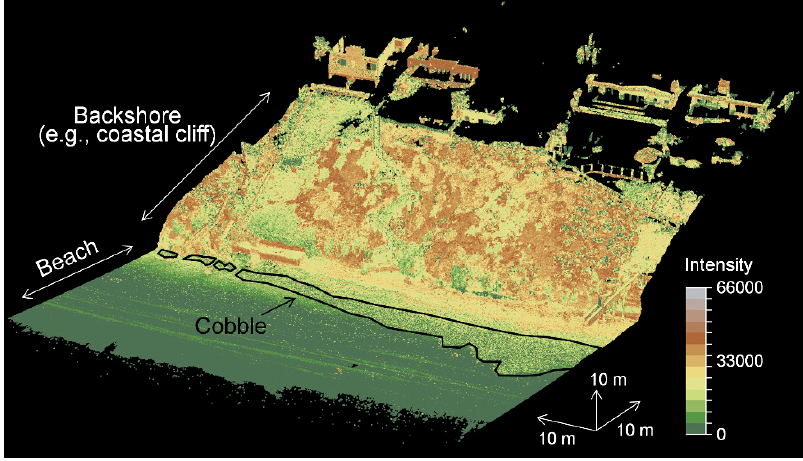
Figure 2. Example of a 3-D point cloud obtained from the mobile LiDAR system, colored by return intensity. Black lines enclose manually delineated dense cobble surface exposures.